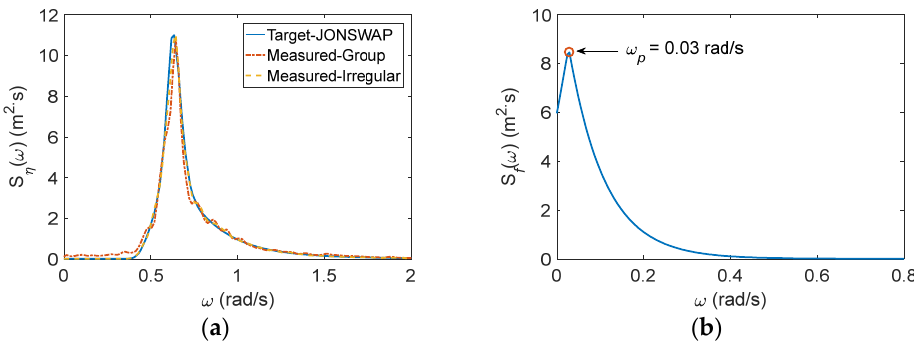
Figure 4. Power Spectra of free surface and wave envelope. ( a ) wave elevation; ( b ) wave envelope.